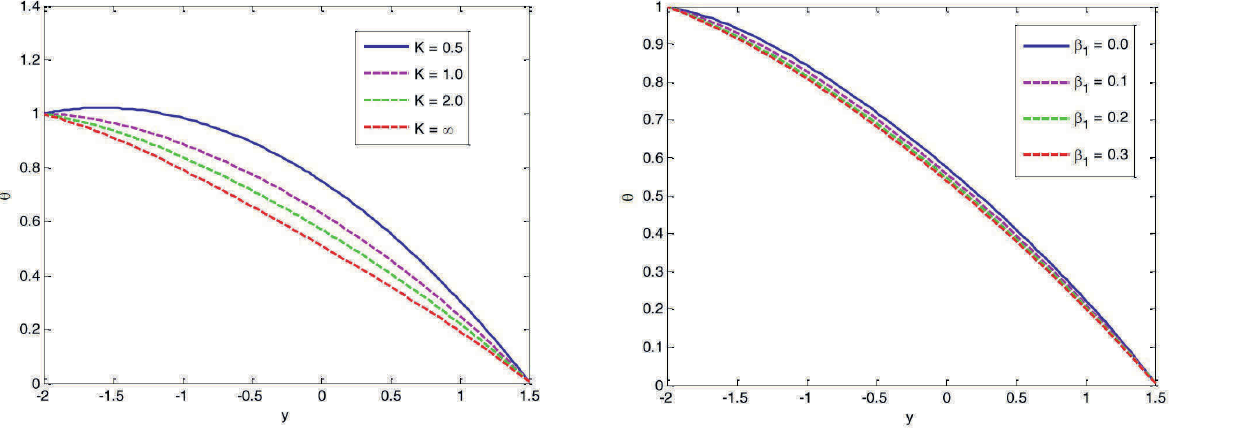
Fig. 14: Impact of first order velocity slip parameter β 1 on tempera- ture.